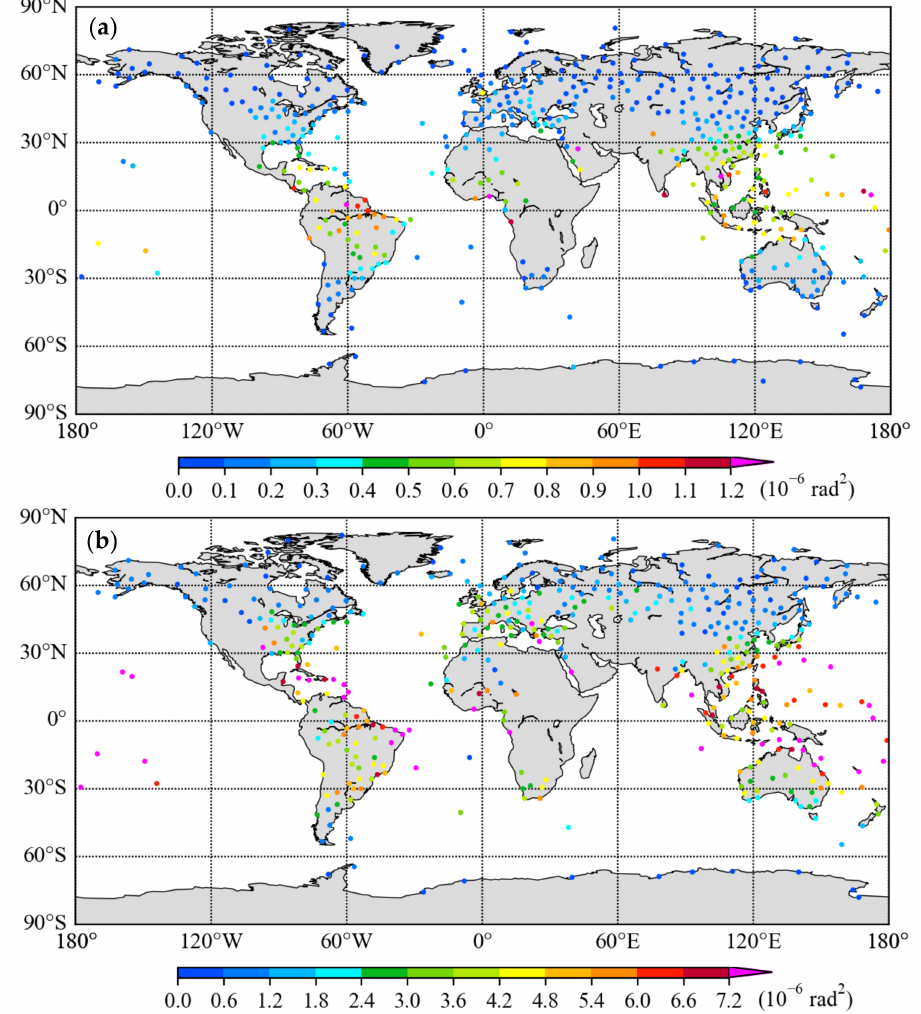
Figure 6. Global distributions of RO bending angle error variances near 521 radiosonde stations at impact heights of ( a ) 6.8 km and ( b ) 3.7